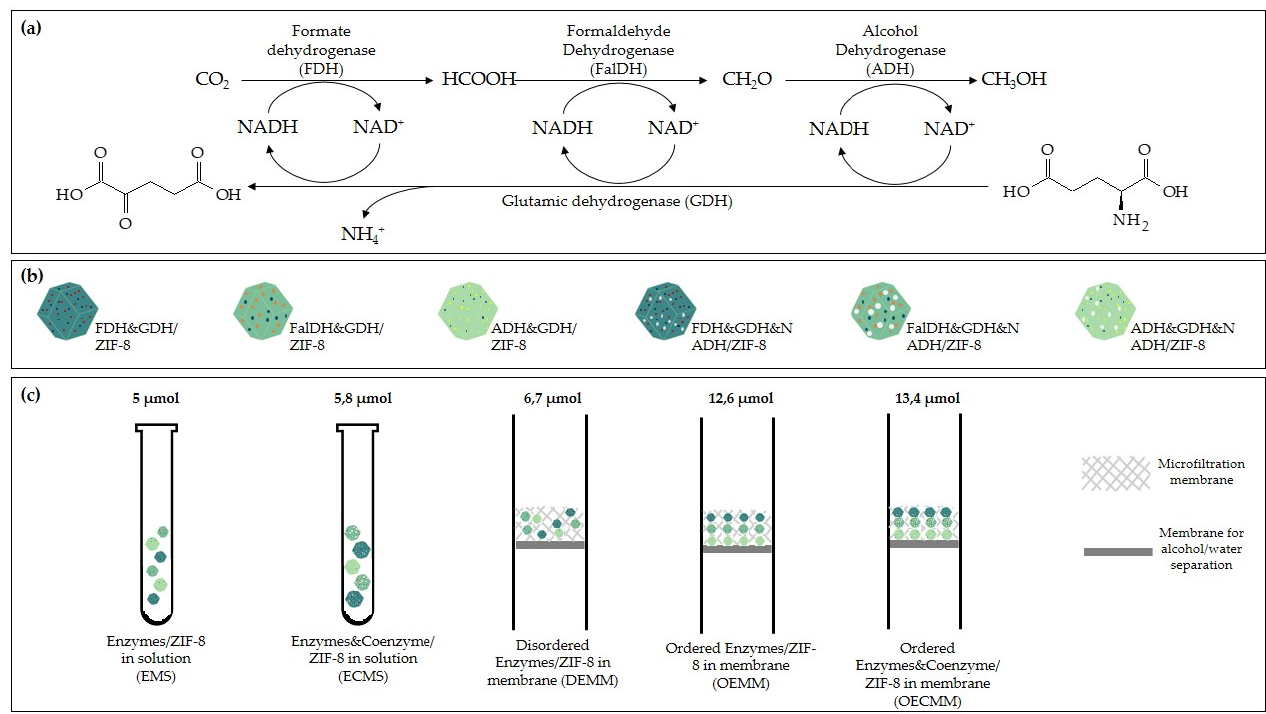
Figure 5. ( a ) Reactions involved in converting CO 2 to methanol and NADH regeneration, ( b ) biocatalysts developed by Zhu and co-workers [84] and ( c ) amount of methanol produced by immobilized enzymes (total flux is 25.30 g · m − 2 · h − 1 and operation time is 6 h).